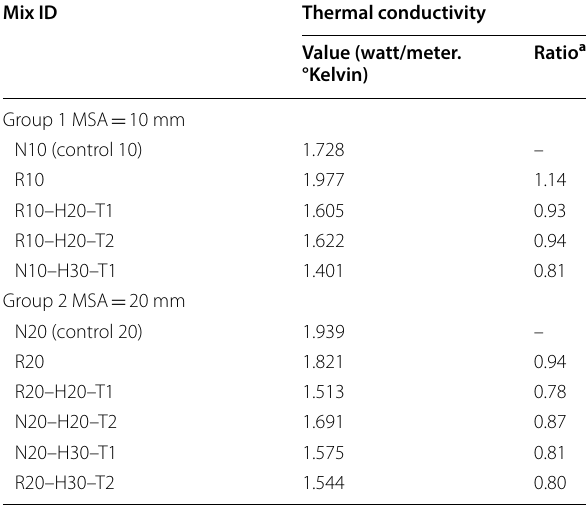
Table 9 Thermal conductivity of the tested